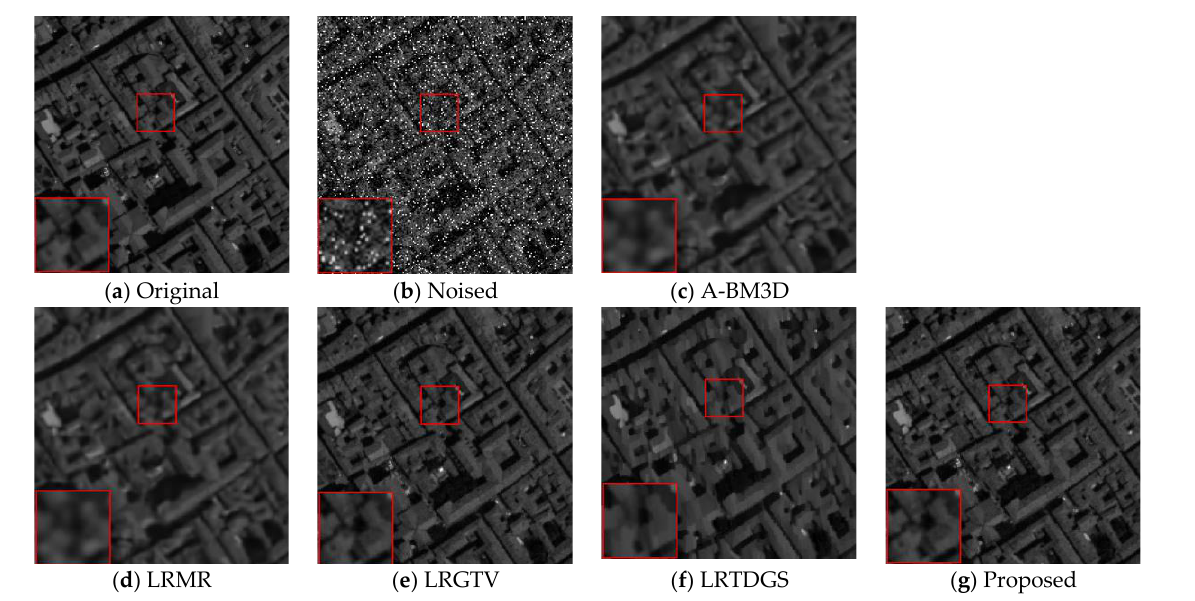
Figure 2. Restored results of band 57 on Simu – Indian. From top to bottom: the results under a sub- case (the standard deviation of zero-mean Gaussian noise is G = 0.10, and the noise proportion of S&P noise is S = 0.20).